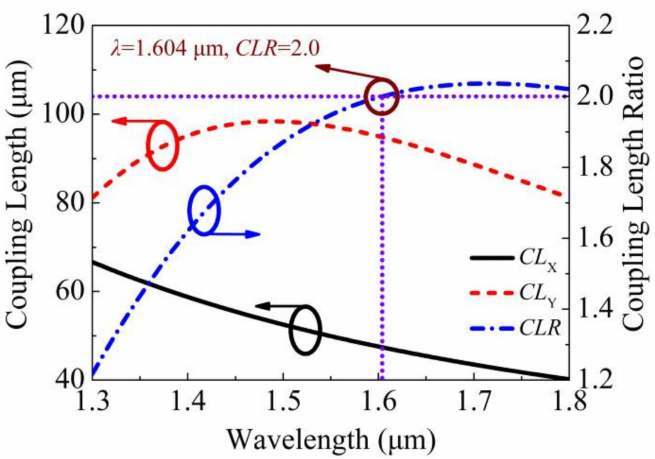
Figure 12. The relationships of the CL X , CL Y , and CLR of the proposed LC-DC-PCF with wavelengths.